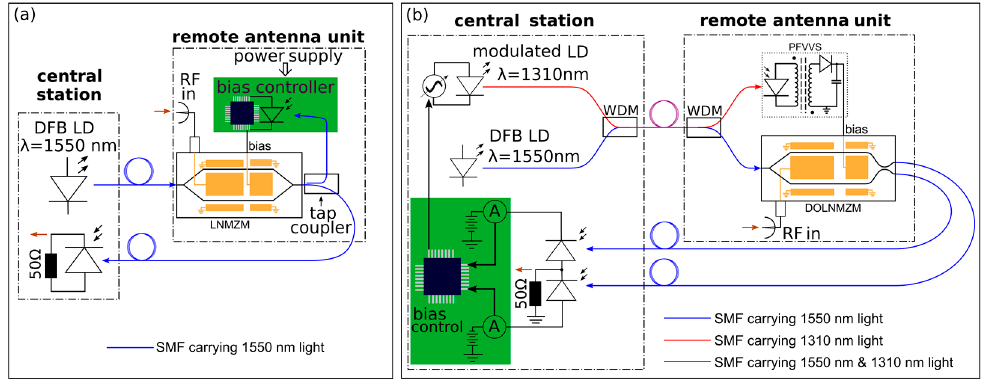
Figure 1. ( a ) Antenna remoting with the RAU consisting of the LNMZM and the operation point control electronics requiring power supply. ( b ) Proposed system of antenna remoting with remote DOLNMZM bias setting using PFVVS.